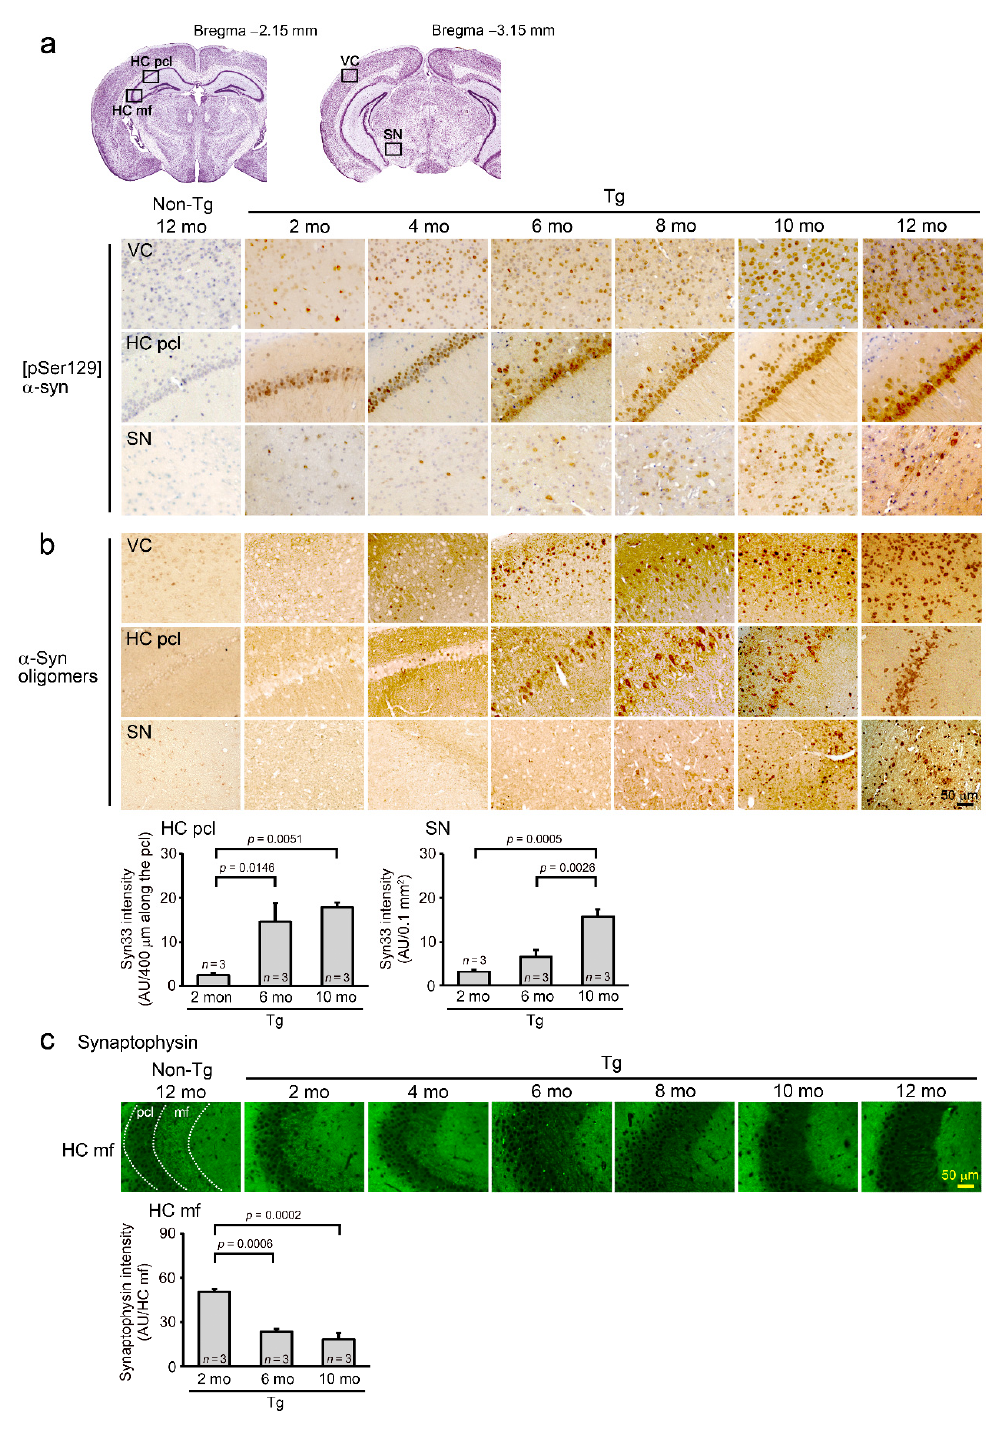
Figure 2. α -Synuclein pathologies in Tg mice. Brain sections prepared at 2, 4, 6, 8, 10, and 12 months old (mo) were stained with antibodies to [pSer129] α -synuclein ( a ), α -synuclein oligomers ( b ), and synaptophysin ( c ). ( a ) [pSer129] α -synuclein was detected in the visual cortex (VC) and hippocampal pyramidal cell layer (HC pcl) as early as 2 months and in the substantia nigra (SN) at 6 months. ( b ) α -Synuclein oligomers first appeared in the VC at 4 months. The accumulation became evident in the HC pcl at 6 months and in the SN at 10 months. Quantification of α -synuclein oligomers was performed in the HC and SN at 2, 6, and 10 months. Syn33 is an antibody to α -synuclein oligomers. ( c ) Synaptophysin in the hippocampal mossy fibers (HC mf) began to decrease at 4 months and were markedly attenuated at 6 months. Dotted lines indicate the boundaries of the HC pcl and HC mf regions. Quantification of synaptophysin was performed in the HC mf at 2, 6, and 10 months using the intensity in the HC pcl as a